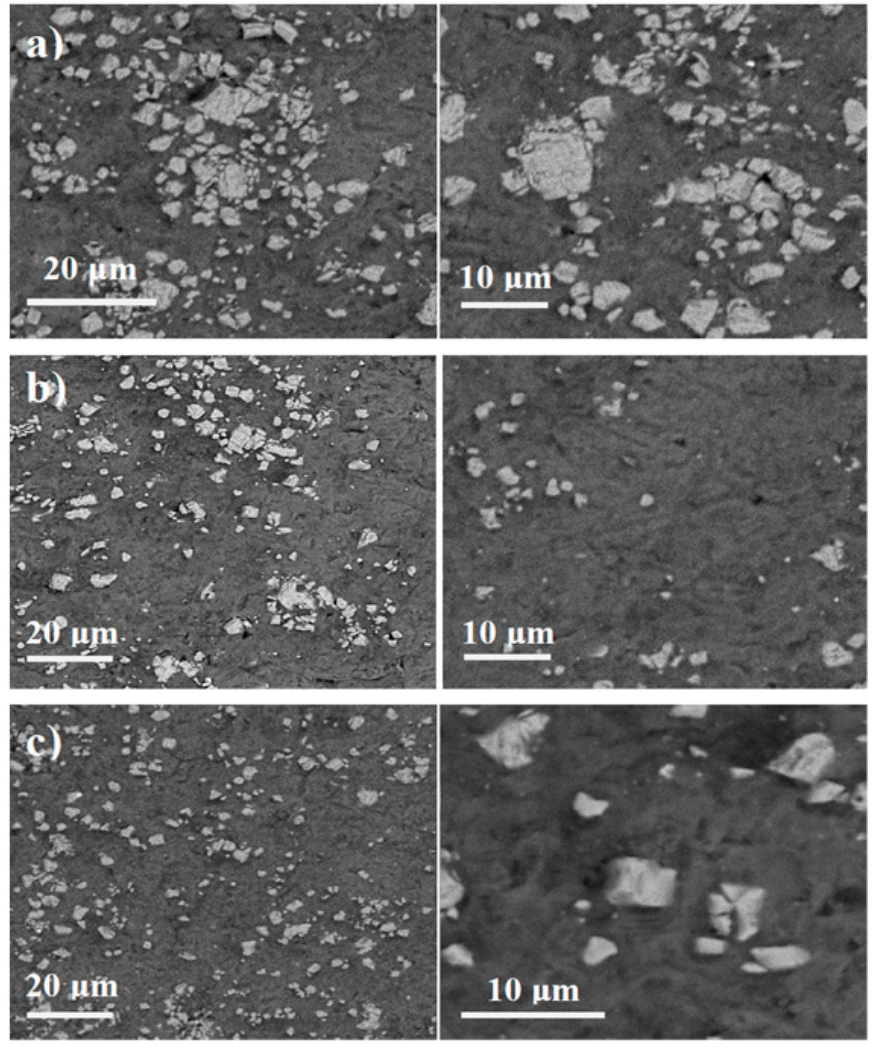
Figure 5. SEM micrograph of: ( a ) conventional; ( b ) microwave; and ( c ) SPS sintered samples.